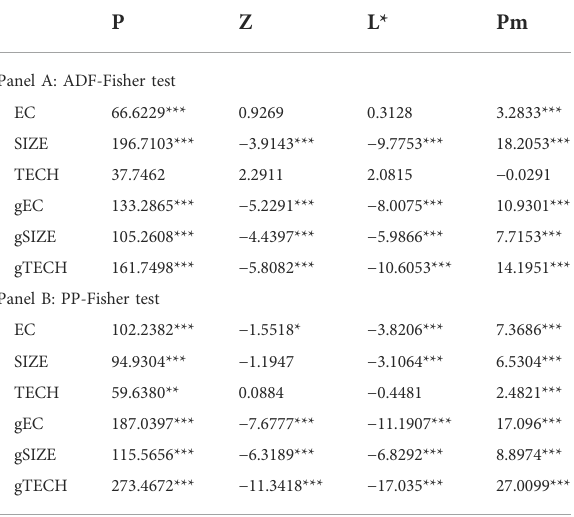
TABLE 4 Regression results of PVAR